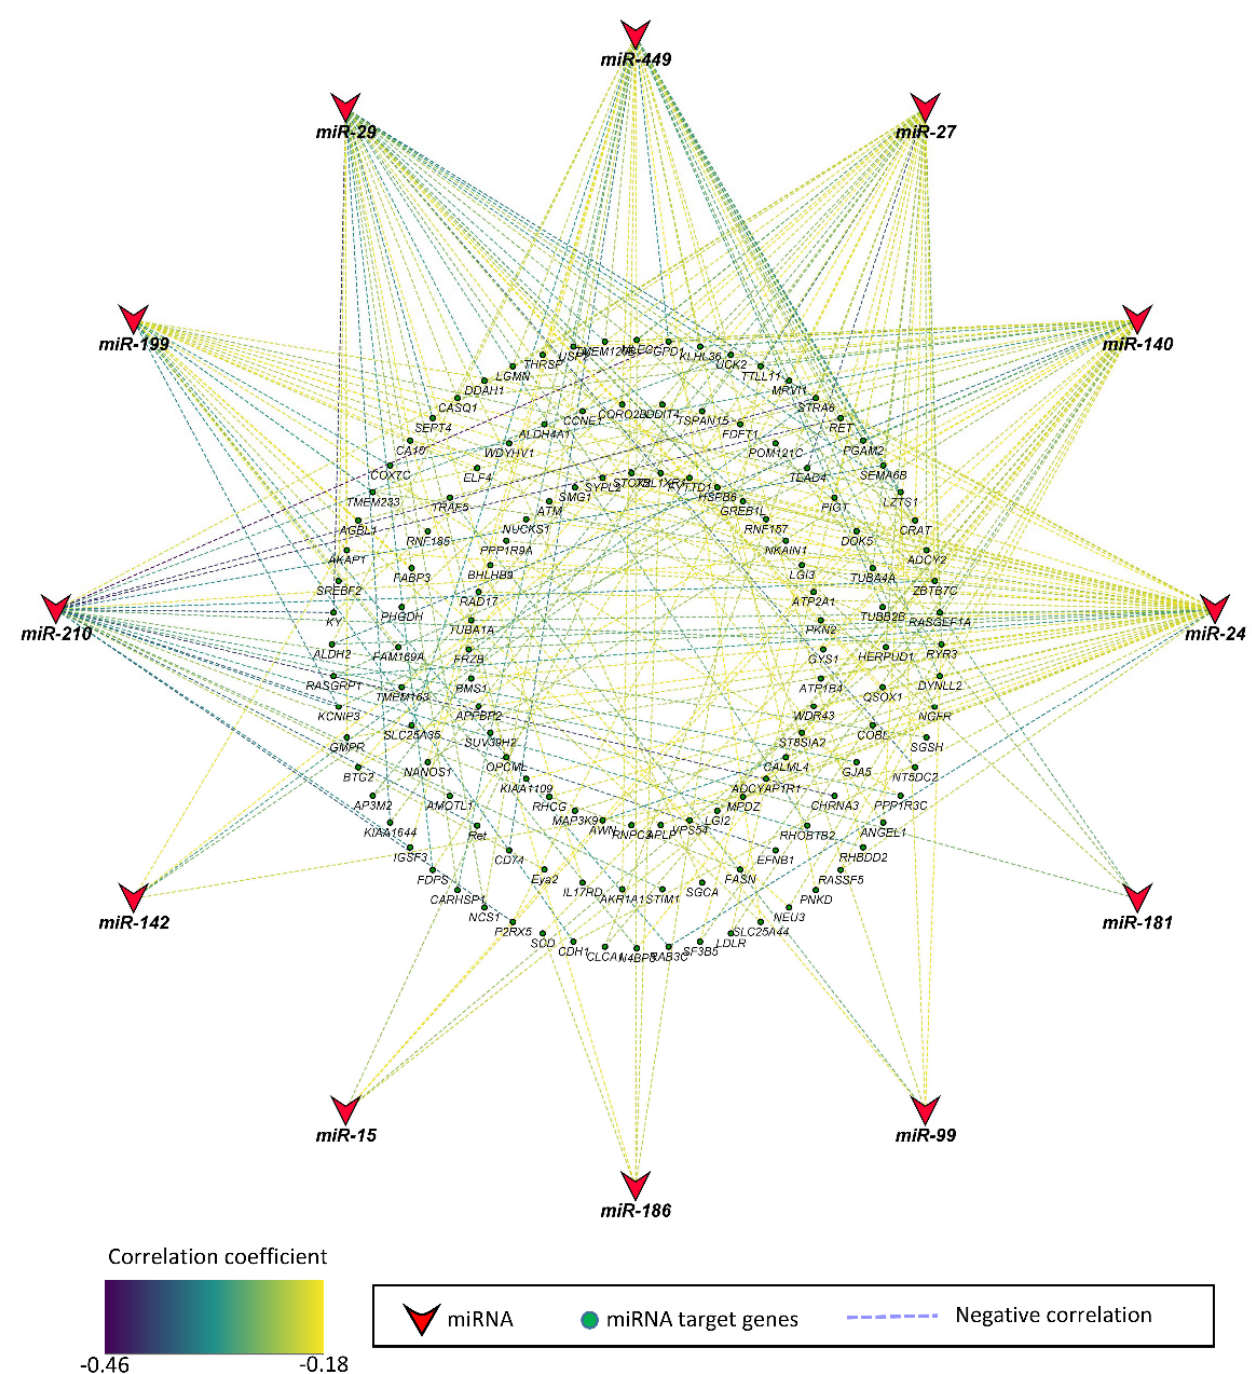
Figure 2. Correlation network of miRNAs and their target genes correlated to fetal weight at 63 dpc. The stroke color indicates the value of correlation coefficient according to the color key. The correlation coefficient ranged from − 0.18 to − 0.45.